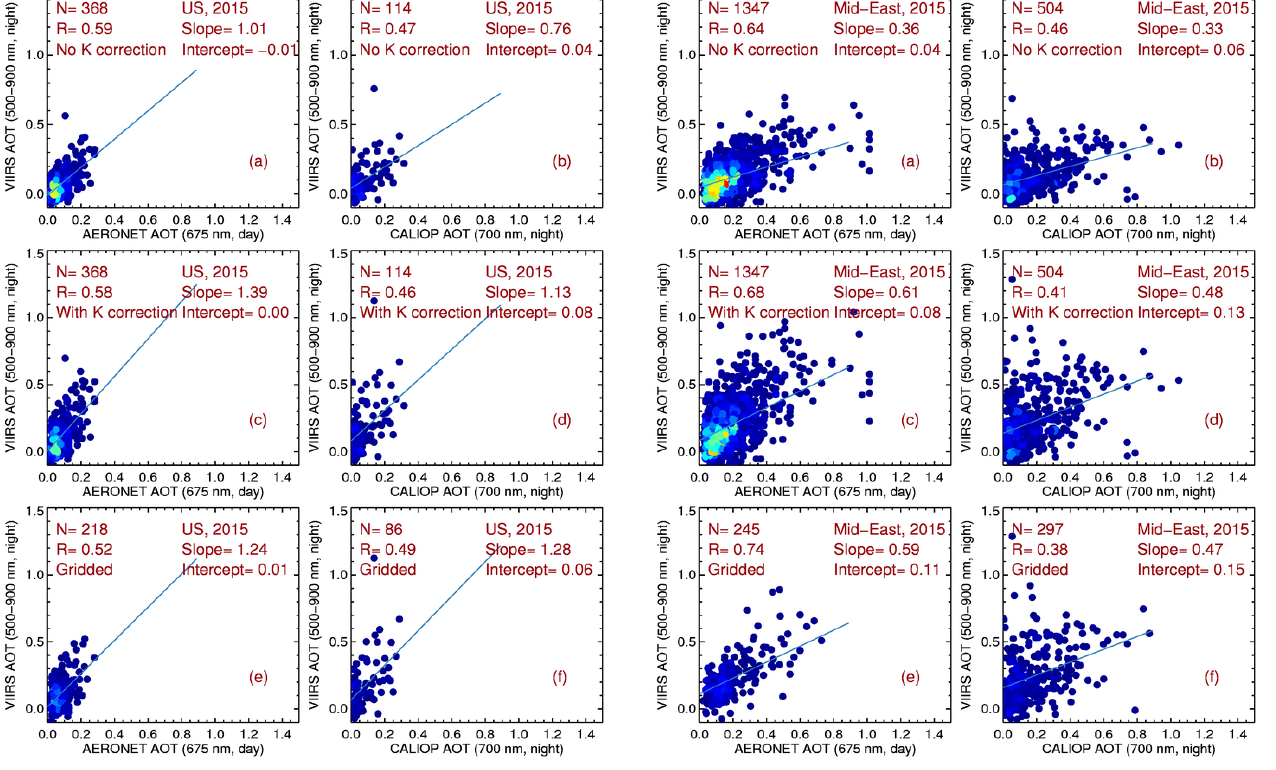
Figure 6. (a) Scatterplot of VIIRS nighttime AOT versus adjacent daytime AERONET AOT (0.675µm) for 200 selected cities over the US for 2015. No diffuse correction is applied. Panel (b) is similar to (a) but using nighttime CALIOP AOT (0.7µm). Panels (c) and (d) are similar to panels (a) and (b) but with the diffuse correc- tion implemented. Panels (e) and (f) are similar to (c) and (d) but for gridded VIIRS data (averaged into 1 ◦ × 1 ◦ latitude by longitude grids). Artificial light sources with fewer than 20 nights that passed various cloud screening and QA checks are excluded. Cold to warm colors represent data density from low to high.